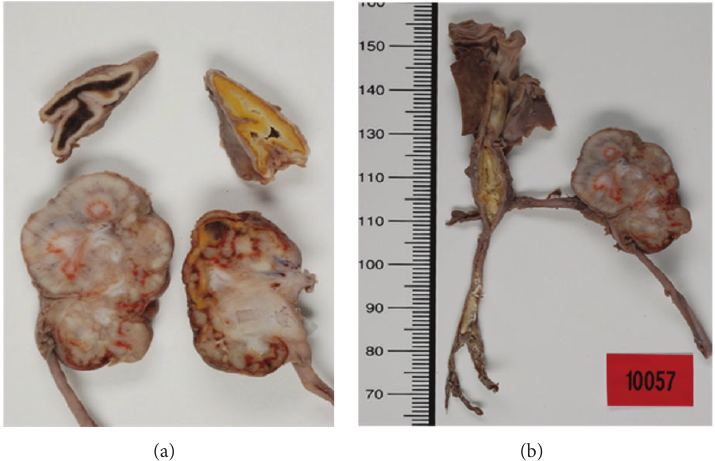
Figure 2: Normal right renal vein and threadlike, nonpermeable left renal vein with a white chalky